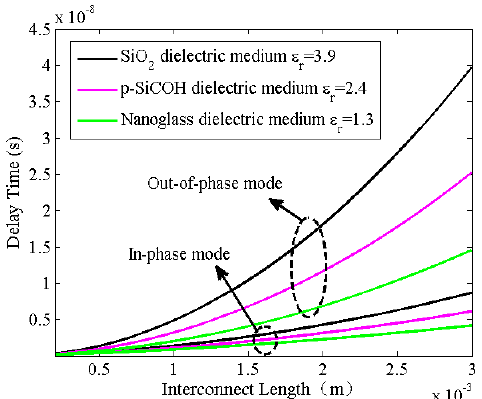
Figure 3. The impacts of different dielectric materials on crosstalk delay of victim line versus Figure3. Theimpactsofdi ff erentdielectricmaterialsoncrosstalkdelayofvictimlineversusinterconnect interconnect length under in-phase and out-of-phase modes. length under in-phase and out-of-phase